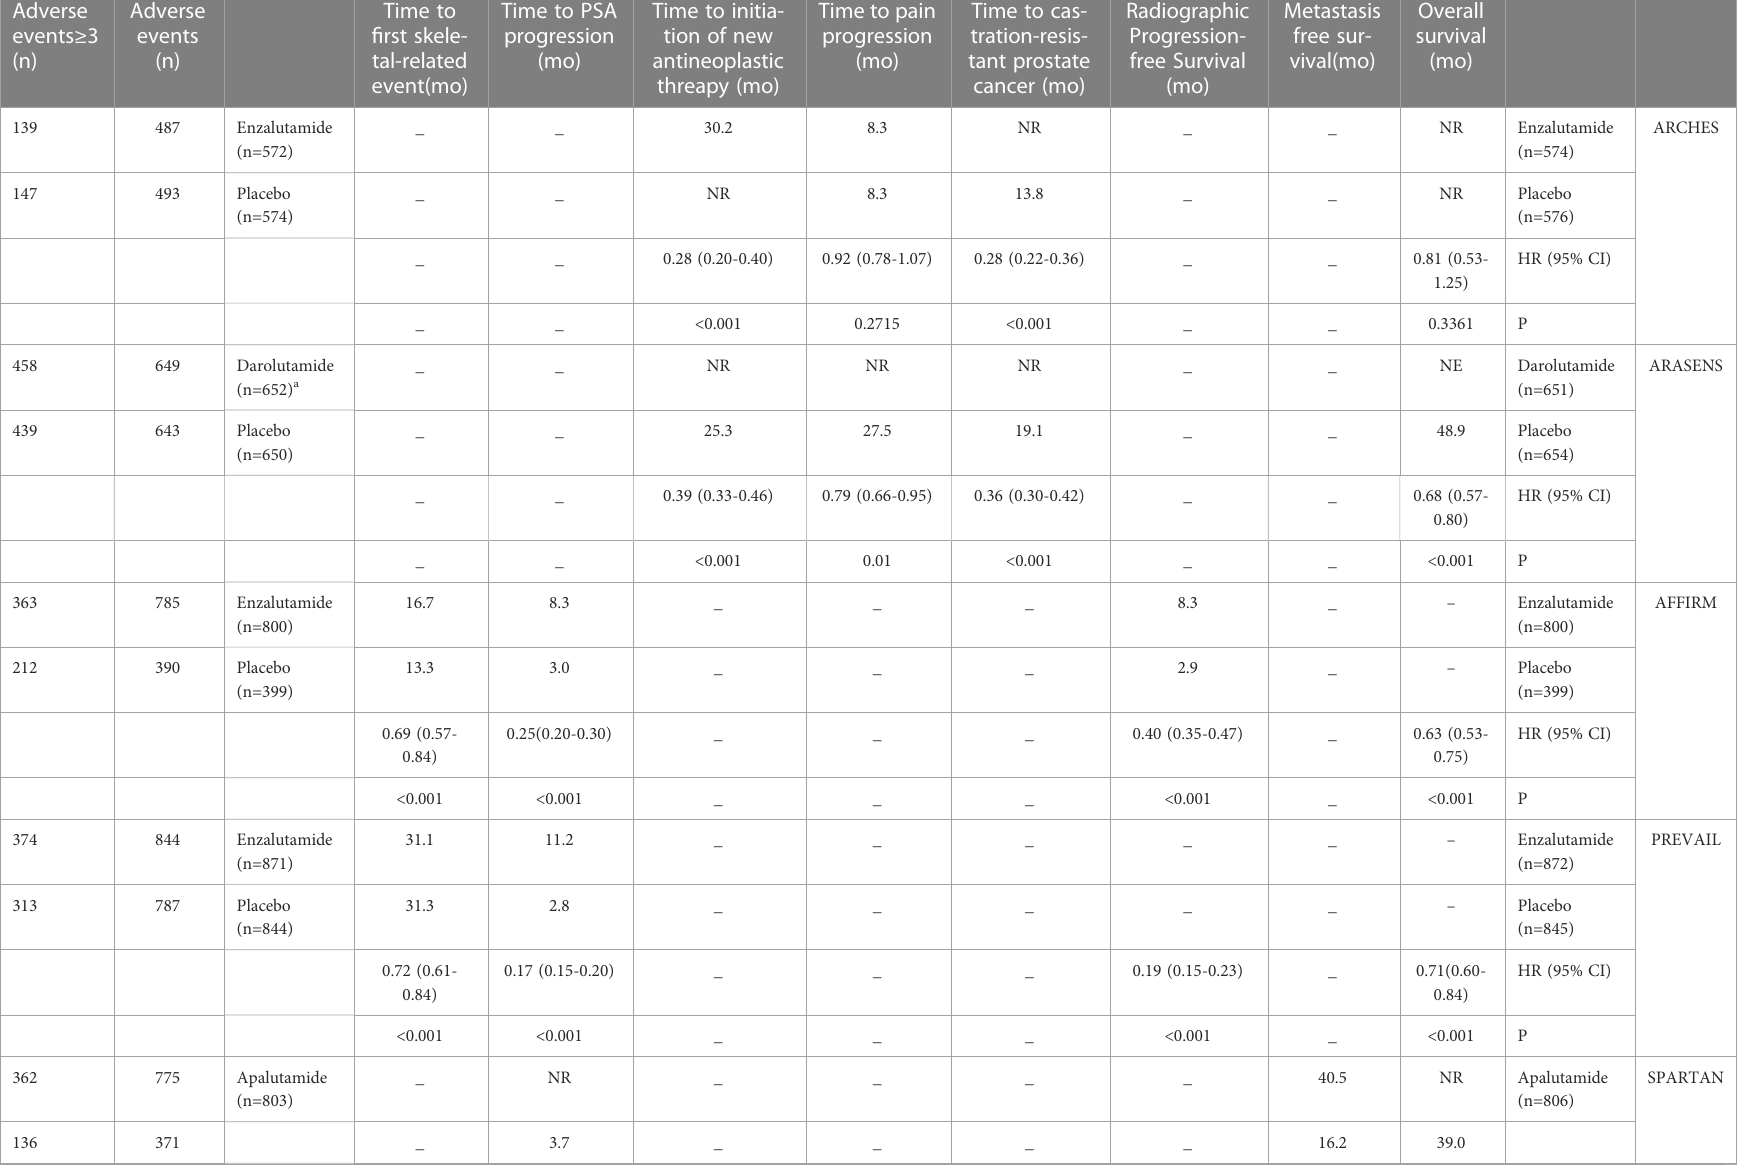
TABLE 2 Summary results of the trial endpoints included in the